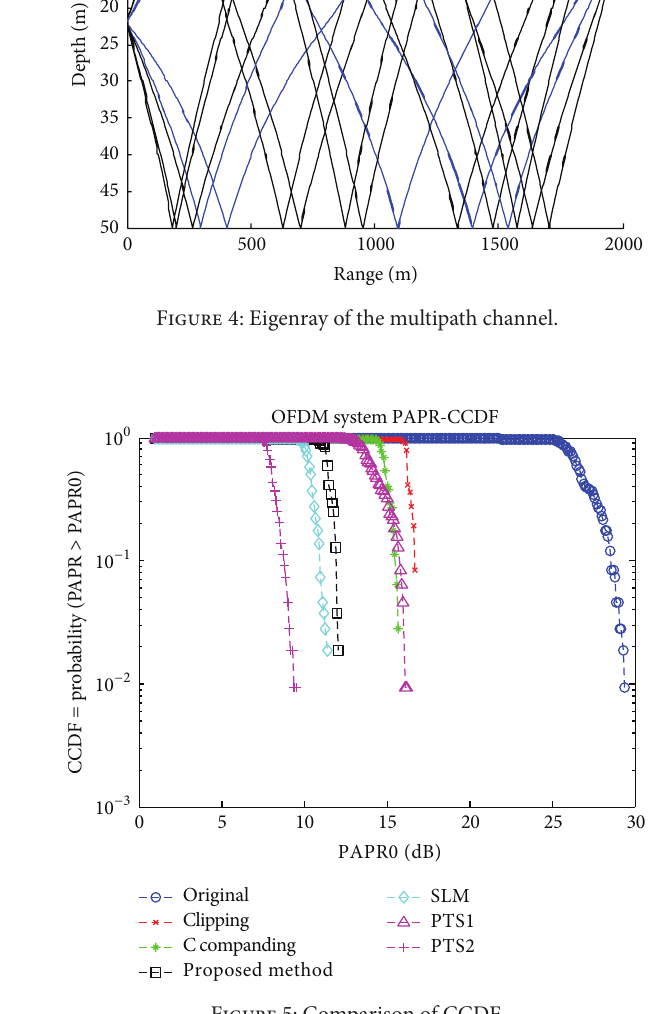
Figure 5: Comparison of